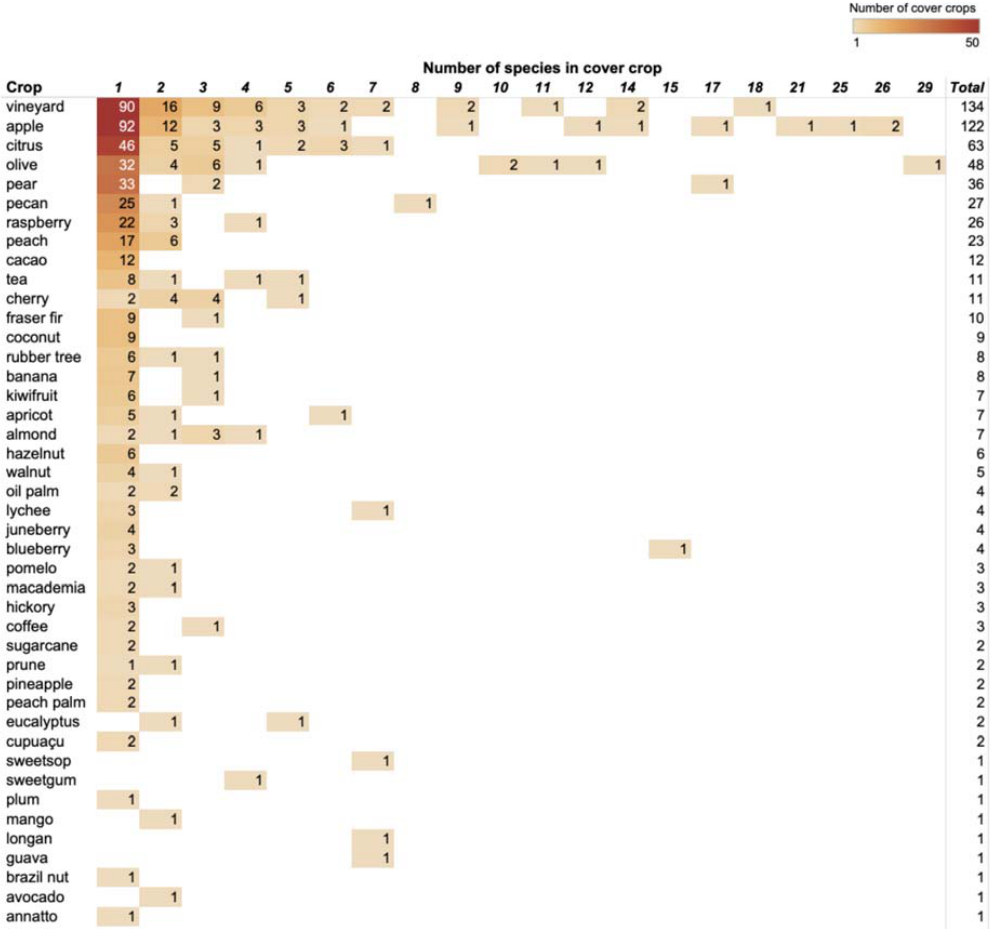
Figure 5. Design of cover crop seed mixes. Cover crop designs are indicated by the number of species assembled in each cover crop. The number of cover crops tested per design is indicated by the cells’ coloration and annotation. Commodities are listed in order of research coverage.